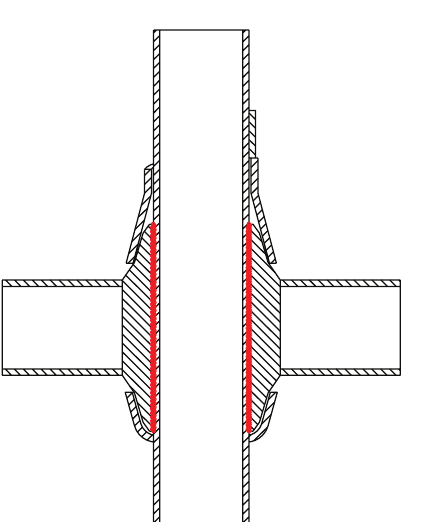
Figure 2: Cross section of cuplock connection.